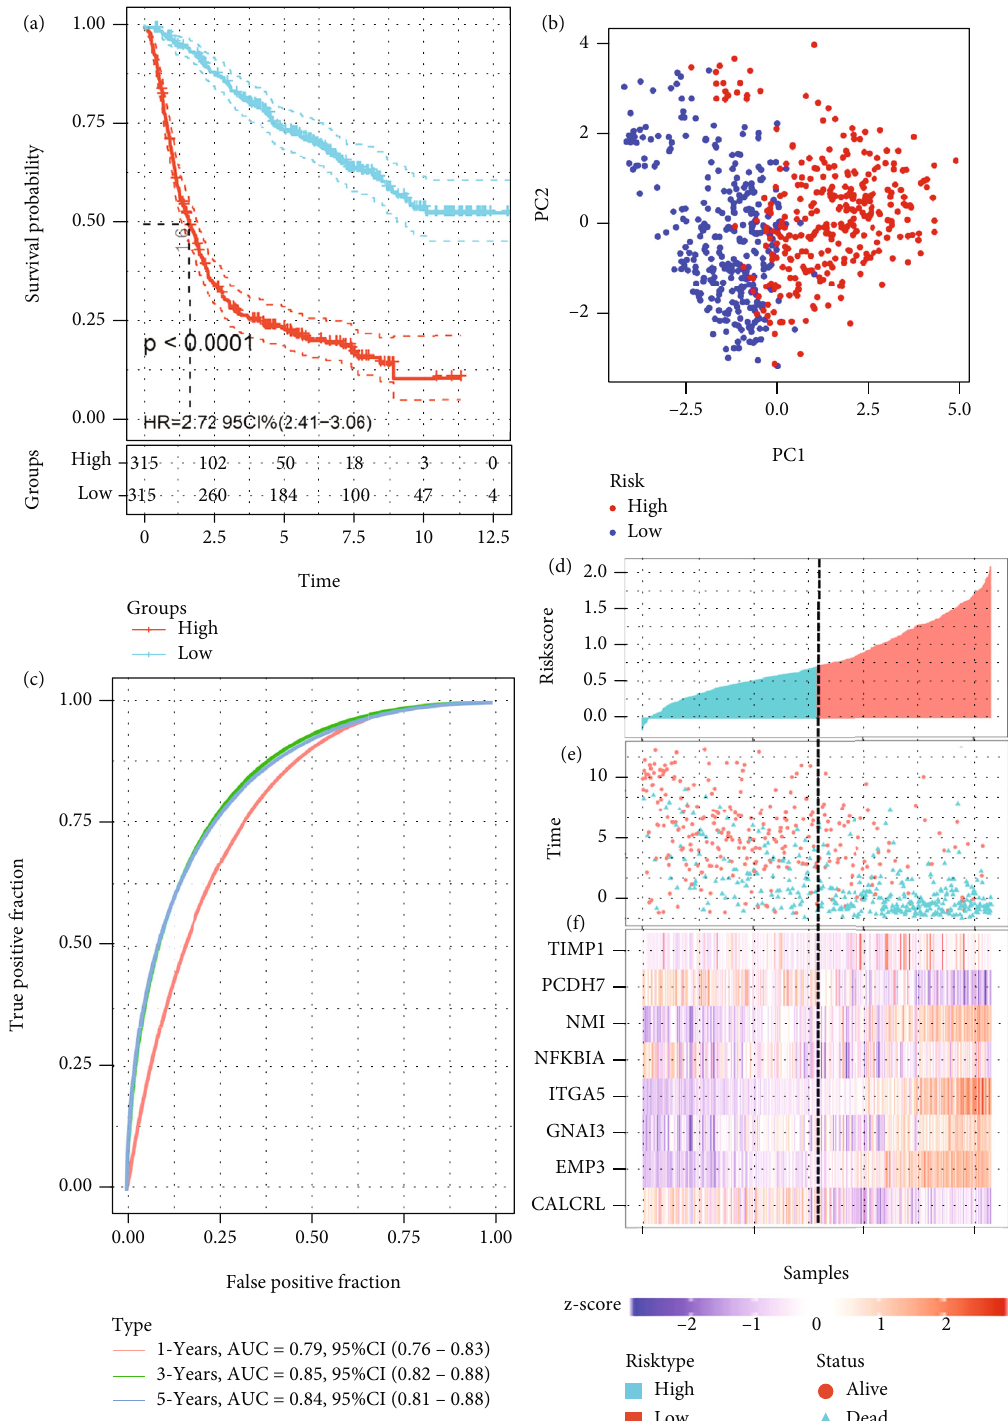
Figure 3: Prognostic analysis using the IRRG signature in the CGGA cohort. (a) Kaplan – Meier curve for OS prediction in the low- and high-risk groups in the CGGA cohort. (b) PCA shows the separation between low- and high-risk groups in the CGGA cohort. (c) The prognostic values of the IRRG signature at 1, 3, and 5 years via time-dependent ROC curve analysis in the CGGA cohort. (d) The risk score distribution for each patient in the CGGA cohort. (e) The distribution of survival time and survival status in the CGGA cohort. (f) The heat map shows that GNAI, EMP3, TIMP1, ITGA5, and NMI exhibit high expression levels, whereas PCDH7, NFKBIA, and CALCRL show low expression levels in the CGGA